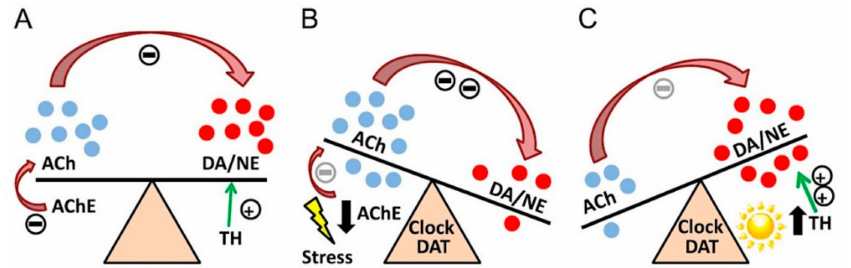
Figure 2. Theory of catecholaminergic–cholinergic balance in physiology, BPAD. ( A ) normal; ( B ) Depression; ( C ) Mania; [10]. Image obtained with permission license number: